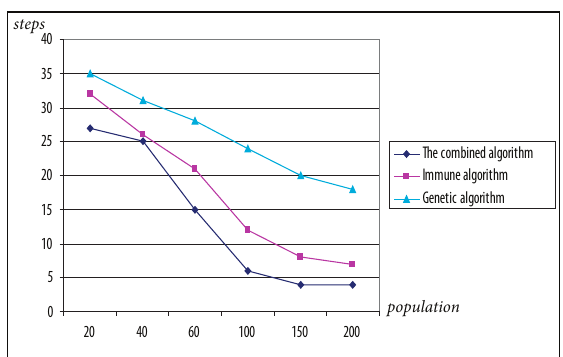
Fig. 6. Convergence rate of various